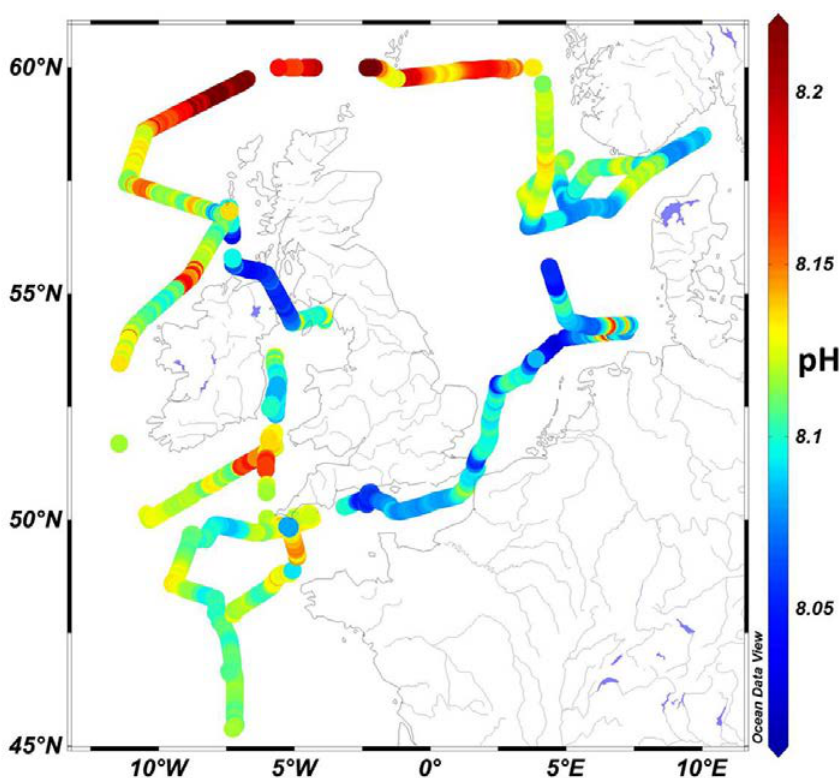
Figure 4. Map of surface water pH tot in European shelf waters for cruise D366 with colour bar indicating pH tot values. Map was produced using Ocean Data View (Schlitzer, R., Ocean Data View, odv.awi.de, 2017).